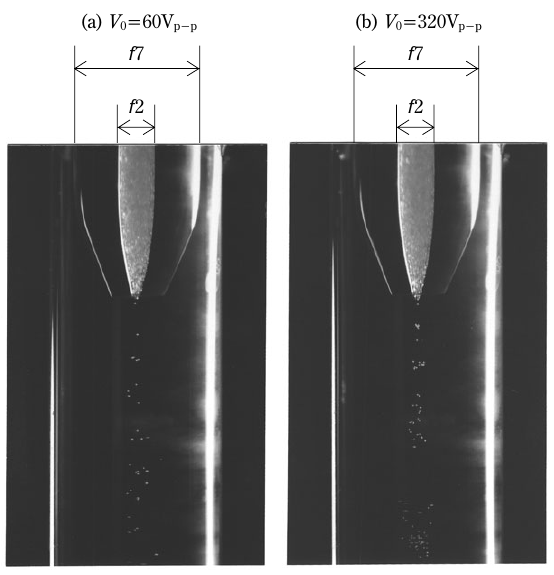
Fig. 4 Representative photographs of particles (Mat-Ms) dis- charged from a nozzle in liquid with ultrasonic wave